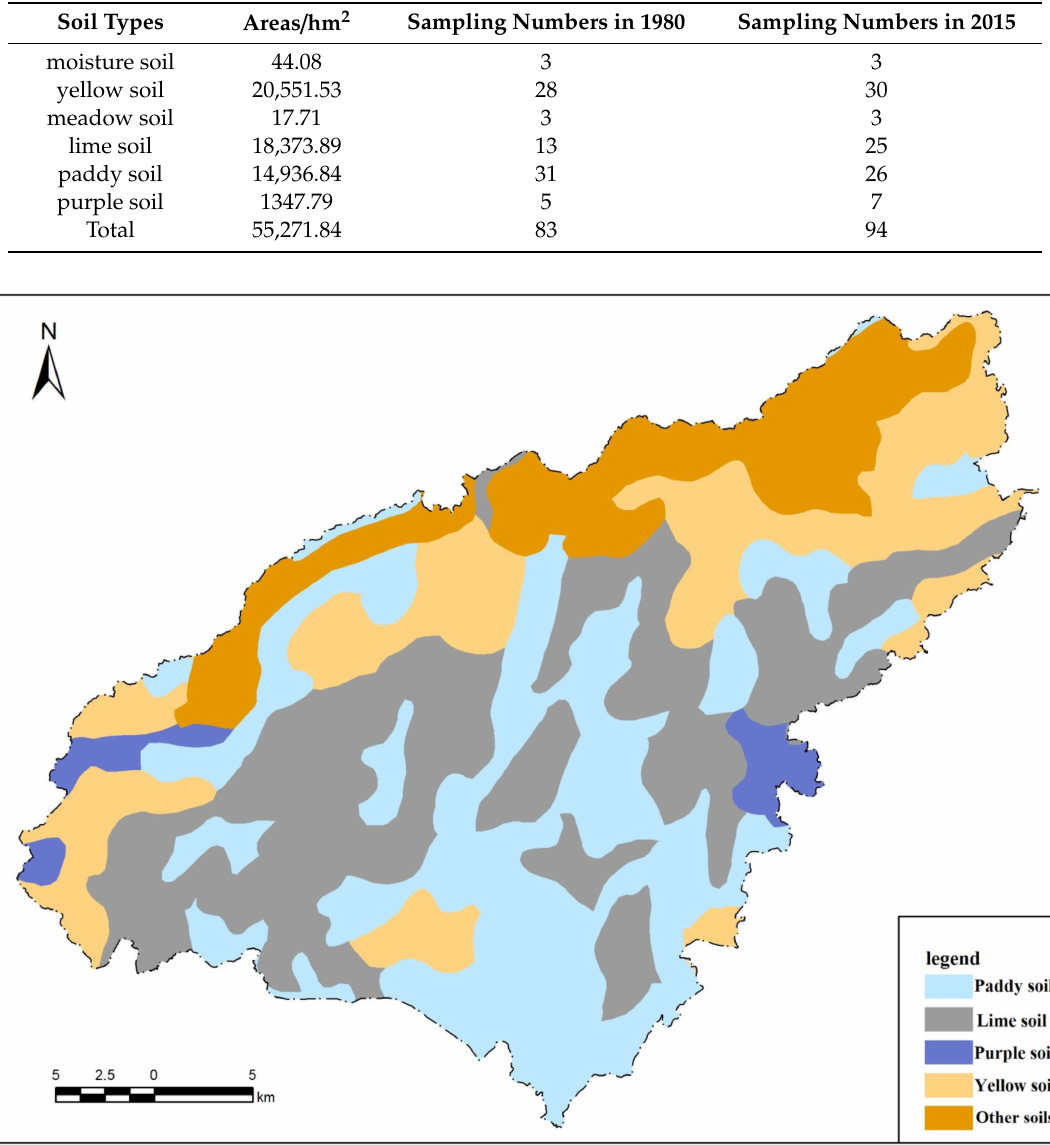
Table 1. Distribution of Soil Area and Survey Sample Statistics in the Study Area.